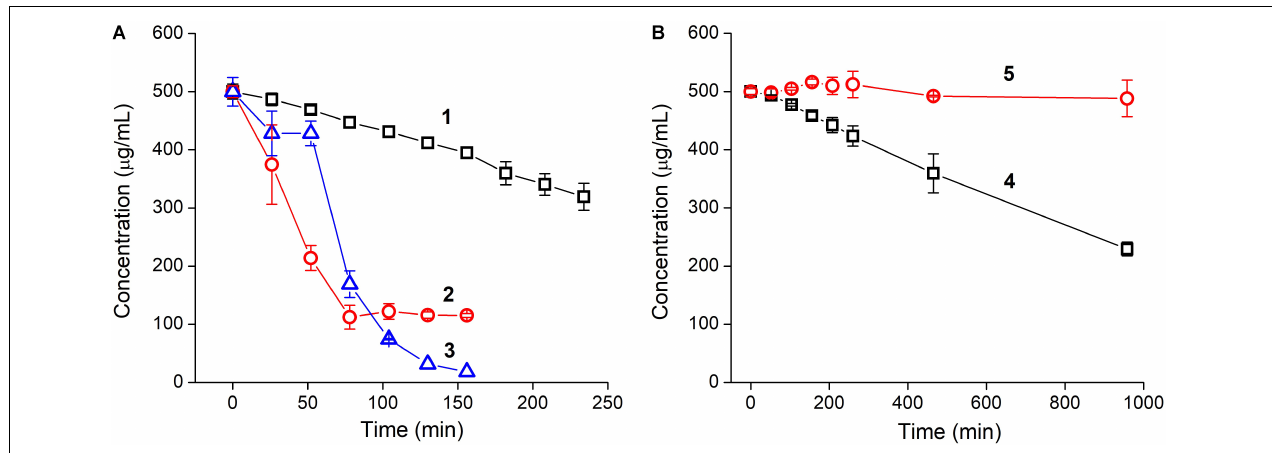
FIGURE 2 | Time kinetics of tryptic cleavage of oligopeptides: (A) YRFK-NH 2 (1), TPP-3-YRFK-NH 2 (2), TPP-6-YRFK-NH 2 (3) and (B) YrFK-NH 2 (4), TPP-6-YrFK-NH 2 (5). Reaction was performed in PBS (pH 7.4) at an initial concentration of oligopeptides of 500 µ g/mL. Remaining concentrations of oligopeptides were measured by means of reversed-phase HPLC. Mean ± SD ( n = 3) are shown.